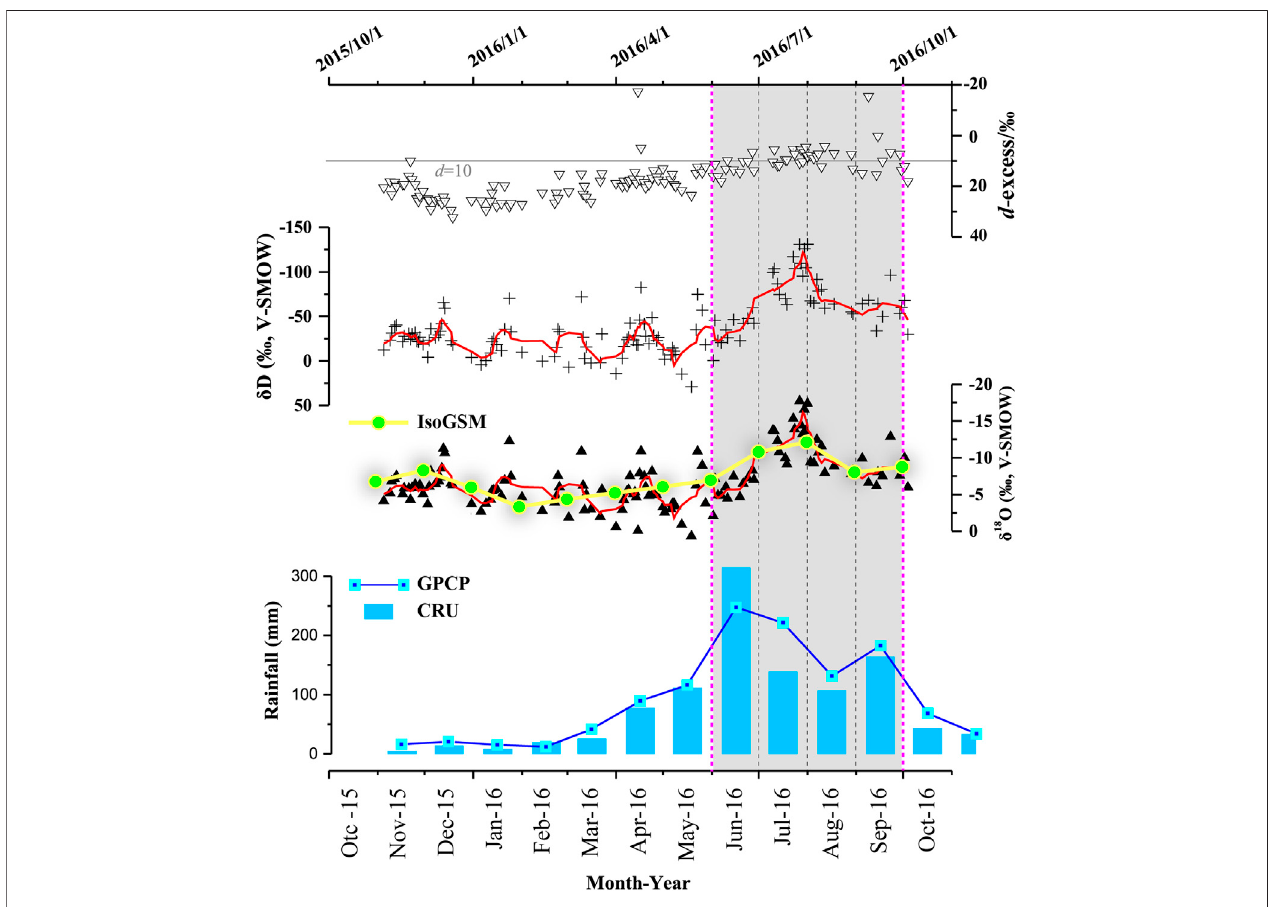
FIGURE2| Precipitation d -excess, δ 18 O, δ Dandthecorrespondingamountofrainfallinourstudyarea.A10-pointssmoothing fi thasbeenappliedtothedata(red line). And the monthly weighted δ 18 O p (yellow point line) near Shenqi cave are based on the IsoGSM (Yoshimura et al., 2008). The GPCP v2.3 and CRU TS4.04 data, usedtoextracttheamountofrainfalldata,canbefoundinthefollowingwebsite:http://climexp.knmi.nl/select.Theyellowverticalbardepictsthewetseasoninthestable isotopes of the precipitation, in fl uenced by the “ super El Niño ” event and the corelated anomalous WPSH.